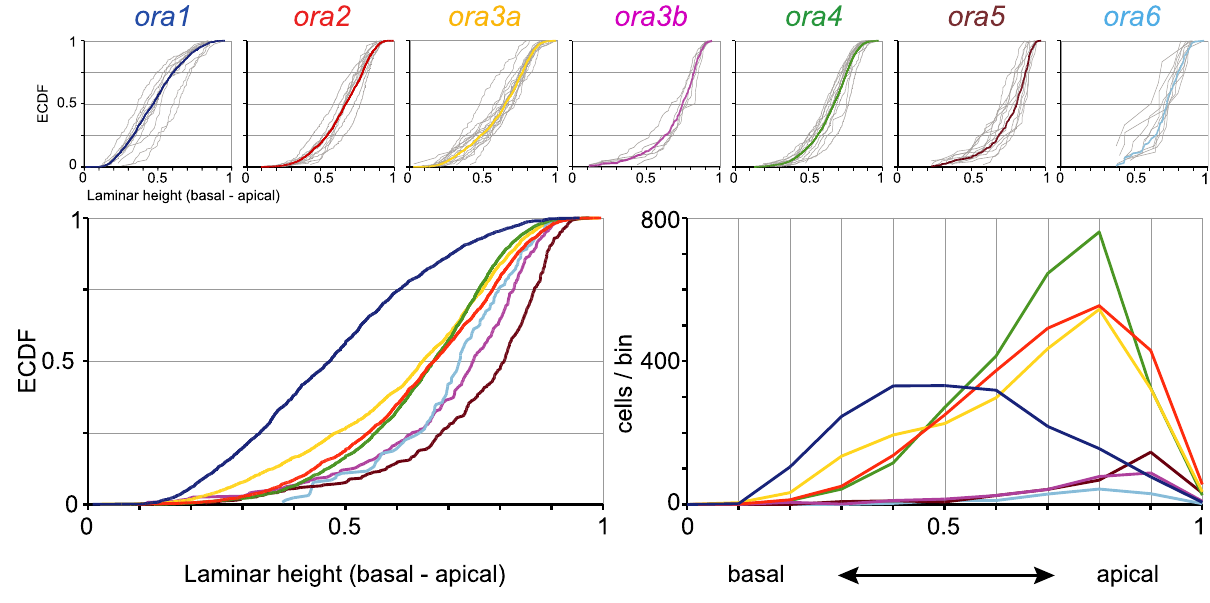
Figure 4. Quantitative assessment of laminar height distributions of ora -expressing neurons. Laminar height of ora -expressing cells was quantified for all seven ora genes. Complete series of sections from five to fifteen olfactory epithelia were evaluated for each ora gene. Height within the lamina was normalized to maximal laminar thickness at the position of the cell. Upper row: The resulting distributions of relative laminar height (from 0, most basal to 1, most apical, i.e., bordering to the lumen) are shown unbinned (ECDF). Light grey curves represent the distribution for individual olfactory organs, colored curves represent the cumulative distribution for the respective genes. The color code for the ora genes is the same as in other figures to facilitate comparisons between different positional parameters. Lower row: Overlay of the seven distributions shown individually in upper row, both as ECDF (left panel) and histogram (right panel). Different genes exhibit different centers-of-gravity (mean) and different